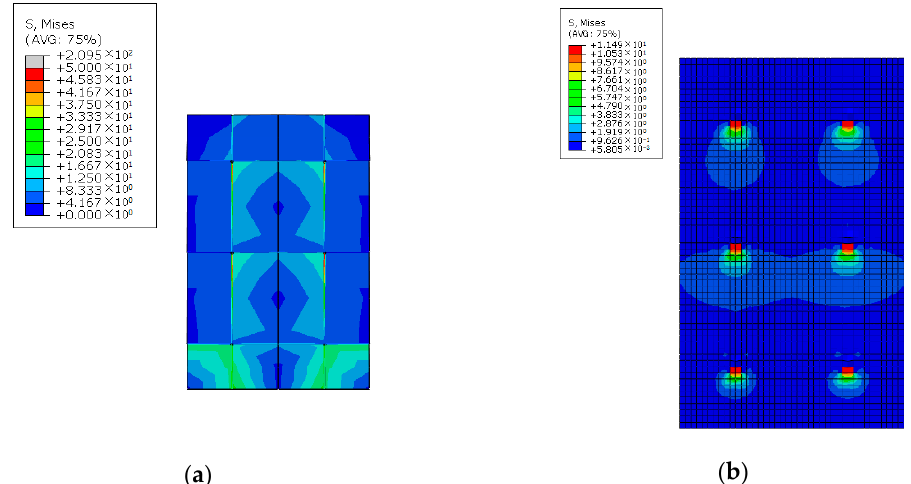
Figure 17. Stress cloud diagrams of the concrete on the outer wall panel. ( a ) Q1 wallboard; ( b ) Q2 wallboard.